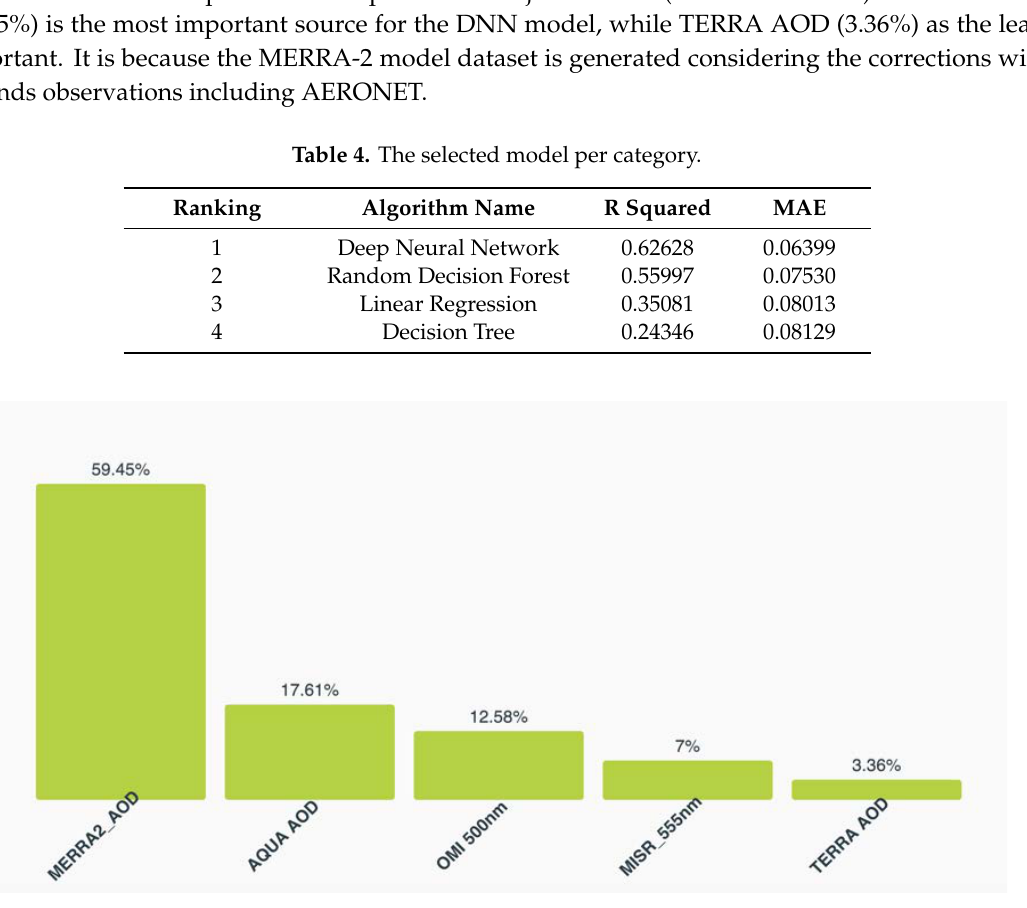
Figure 10. The field importance of parameters for the deep neural network (DNN) model.